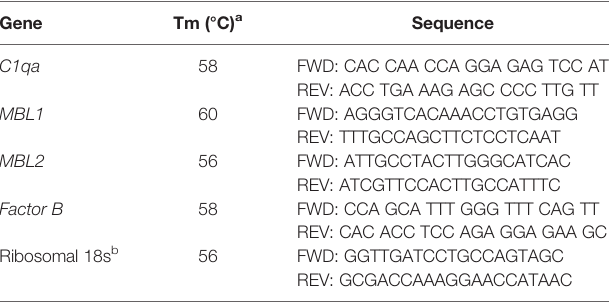
TABLE 1 | Real Time PCR Primer